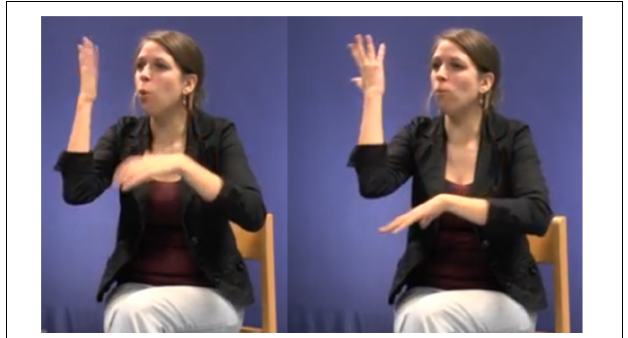
FIGURE 6 | The fully-lexical sign TREE in its citation form, as produced in example 1. Figure reproduced with permission from Corpus VGT (Van Herreweghe et al.,